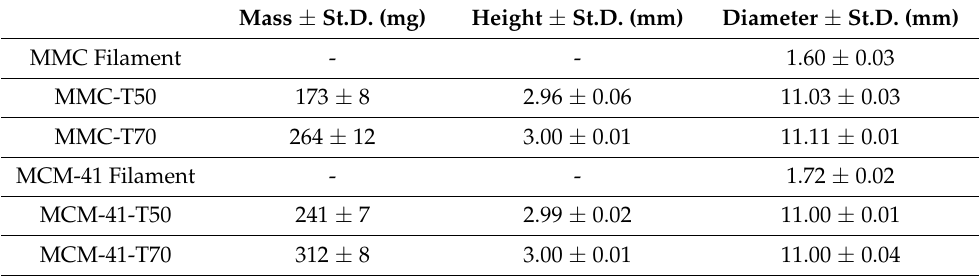
Table 3. Properties of filaments and tablets containing MMC and MCM-41. Mean values and standard deviations are given for the